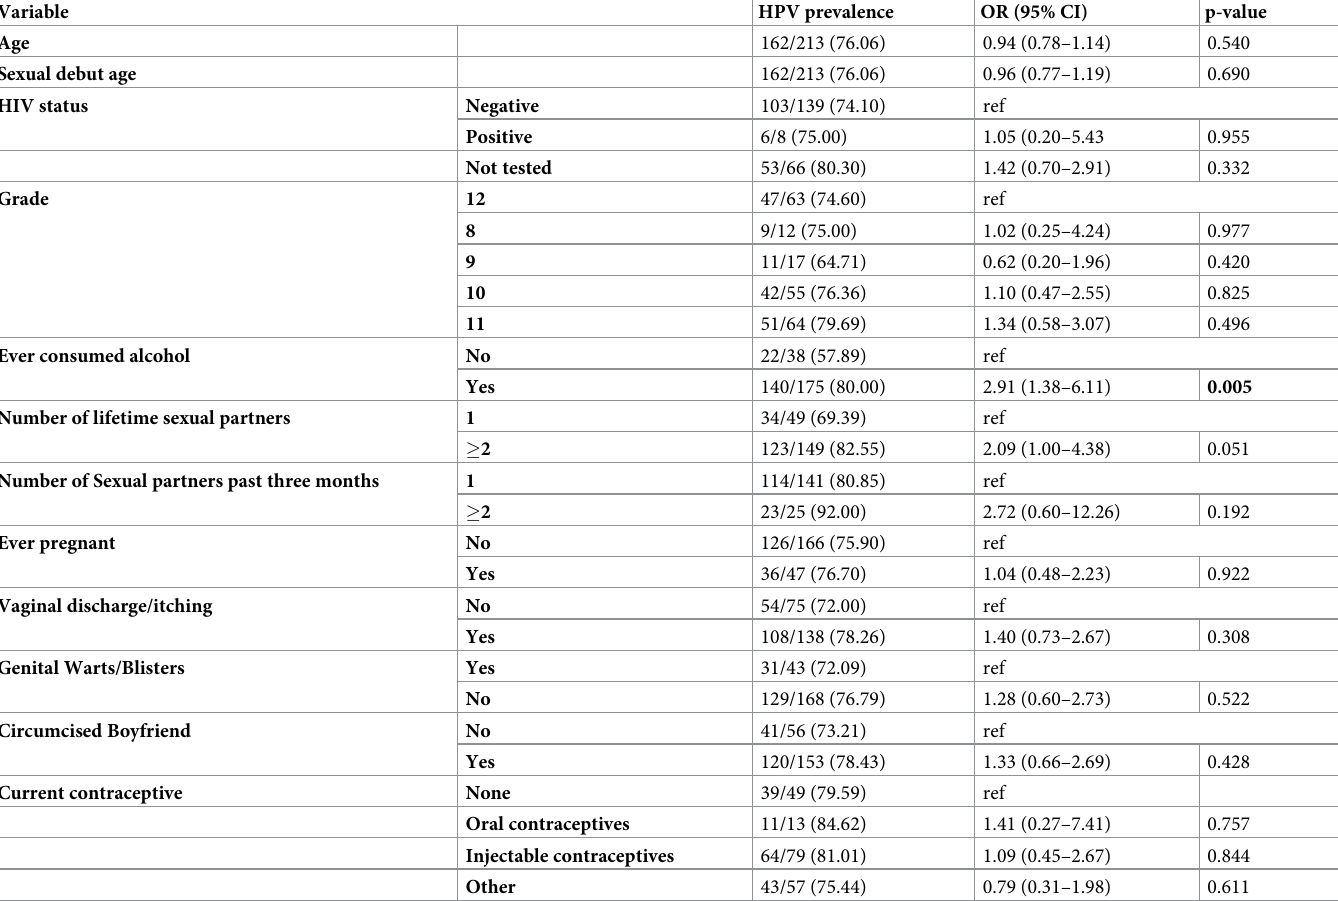
Table 4. Factors associated with human papillomavirus (HPV) prevalence among high school female learners of Eastern